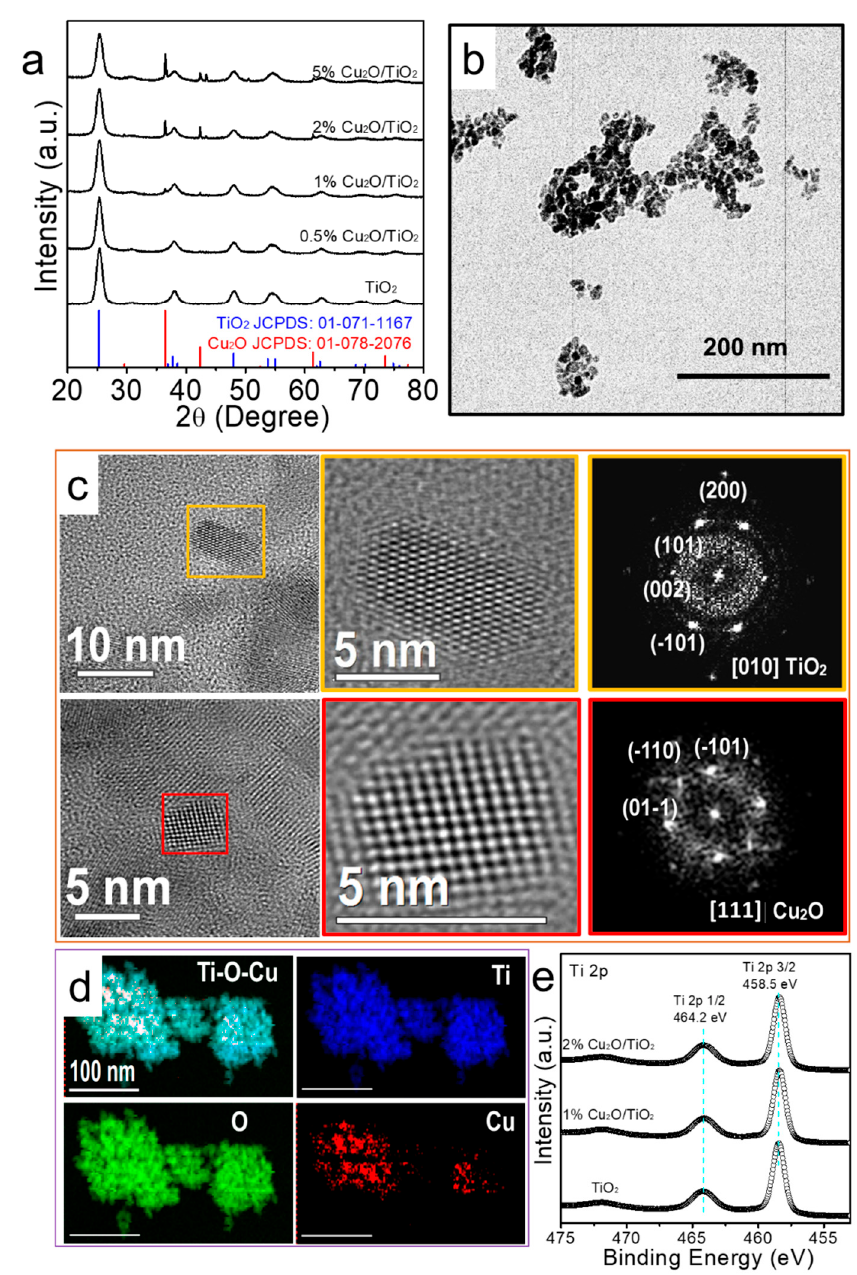
Figure 1. ( a ) Powder XRD pattern of TiO2 and 0.5%, 1%, 2% and 5% Cu2O/TiO2 nanocomposites. ( b ) TEM micrograph of 1% Cu2O/TiO2, with a scale bar of 200nm. ( c ) HRTEM analysis of the 1% Cu2O/TiO2 sample. The upper image shows a crystal with a tetragonal anatase phase of TiO2 visualized along the [010] zone axis. The lower image shows a cubic Cu2O crystallite visualized along the [111] zone axis. ( d ) STEM-ADF and STEM-EELS analysis of the 1% Cu2O/TiO2 sample. Cu L-edges at 931 eV (red), O K-edge at 532 eV (green) and Ti L-edge at 456 eV (blue). ( e ) High resolution XPS spectra for the Ti 2p core level of TiO2 and 1%, 2% Cu2O/TiO2 nanocomposites.